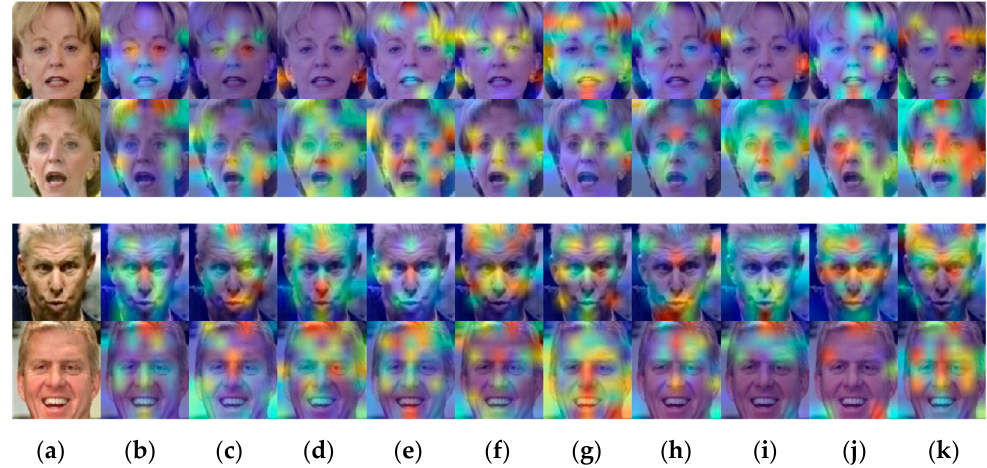
Figure 9. Two random face image pairs from the LFW [40] dataset. The original image pairs are shown in ( a ). Corresponding Grad-CAM visualization for the baseline pair is depicted in ( b ), and other attention modules are depicted from ( c – j ), while the proposed attention module of this work is illustrated in ( k ), all are arranged column-wise from left to right. ( a ) Original face image pairs; ( b ) ConvFaceNeXt; ( c ) SE; ( d ) ECA; ( e ) CBAM; ( f ) ECBAM; ( g ) CA; ( h ) SCA; ( i ) TA; ( j ) DAA; ( k ) LCAM.